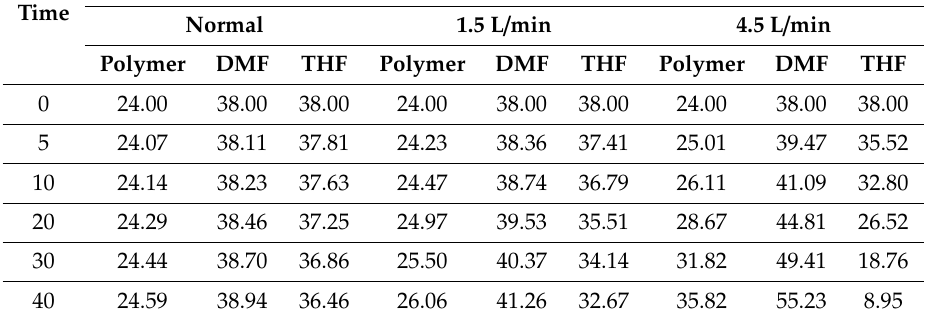
Table 2. Influence of evaporation conditions on the solution composition in an as-cast flat sheet film. The evaporating amount is calculated from the curves in Figure 5a. The as-cast film is cast using 1 mL of 24 wt% PS- b -P4VP 18150 in DMF / THF 1 / 1 (wt / wt), which is estimated to spread in 50 cm 2 area for the thickness of 200 µ